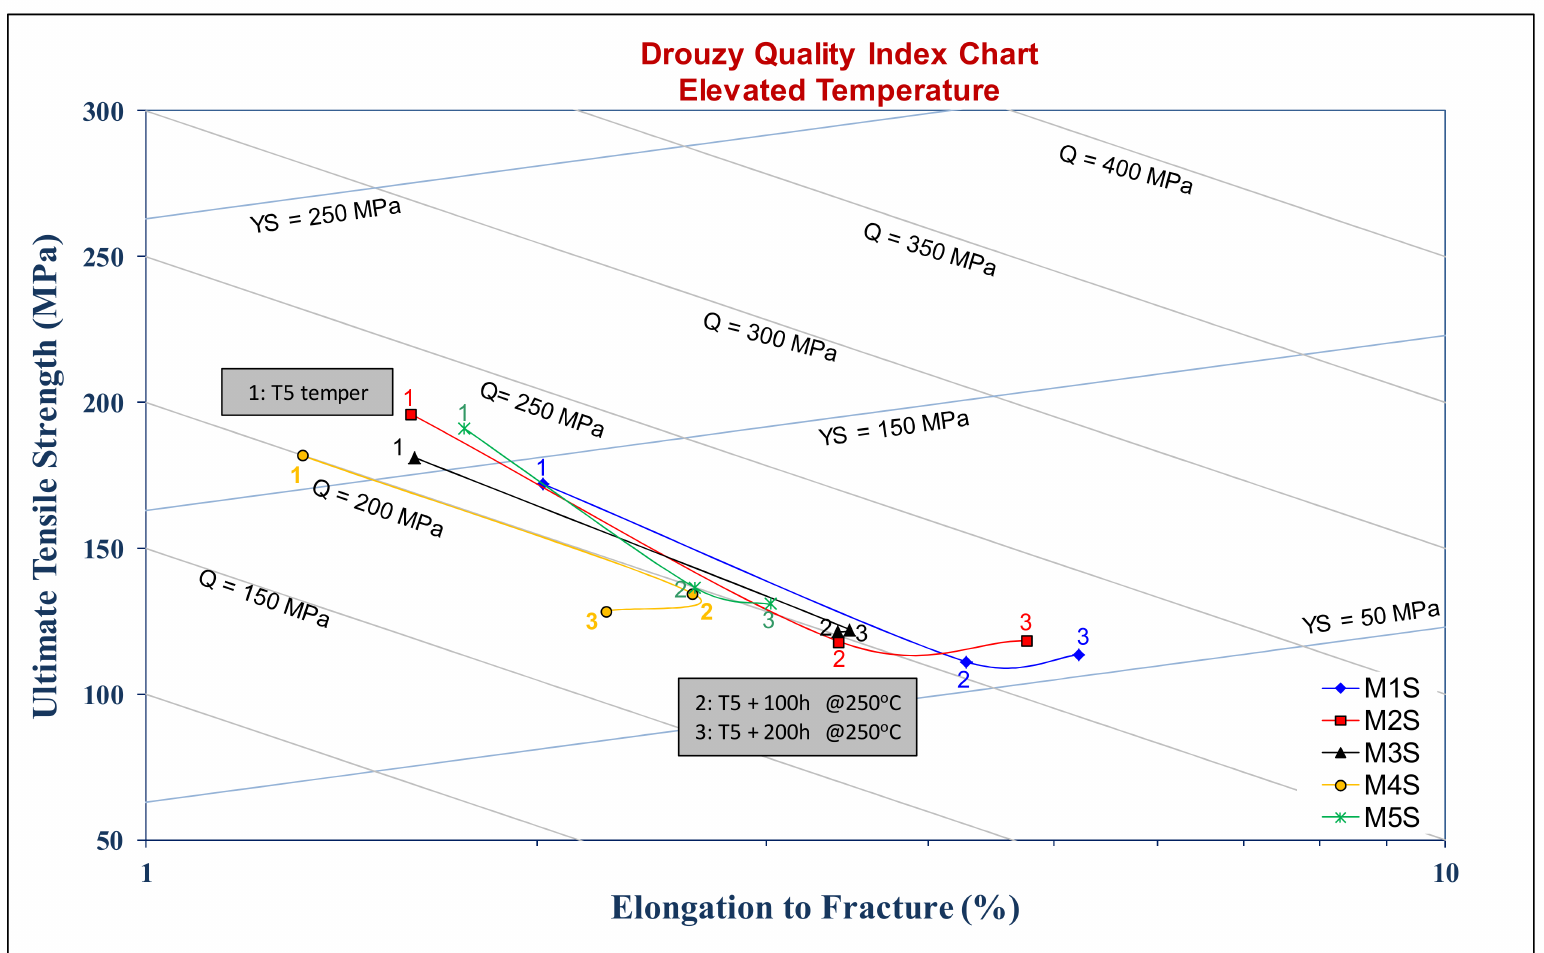
Figure A3. Drouzy quality chart representing the relation between the UTS and the percent elongation to fracture of alloys M1S through M5S in the T5-treated condition, before and after stabilization at 250 ◦ C for 100 and 200 h (testing at 250 ◦